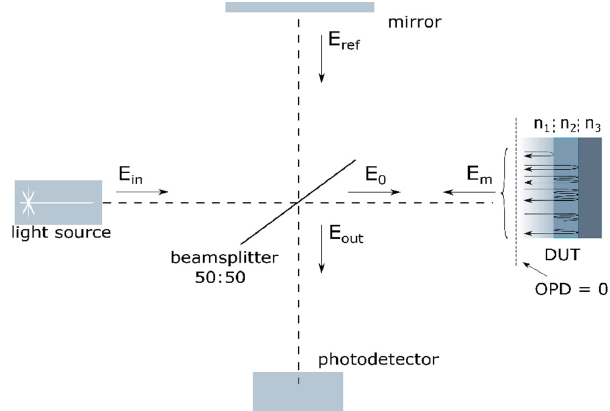
Figure 1. The principle of operation of the optical coherence tomography (OCT) system model. The raw laser beam enters the optical system through the beamsplitter, which separates an incoming wave into a reference and measurement arm. The reference beam is produced by reflection from the mirror, and the measurement beam is sourced from the Fabry–Pérot interferometer. The device under test (DUT) is a thin film with a refractive index n 2 , the medium above the film with refractive index n 1 , and a substrate with refractive index n 3 .